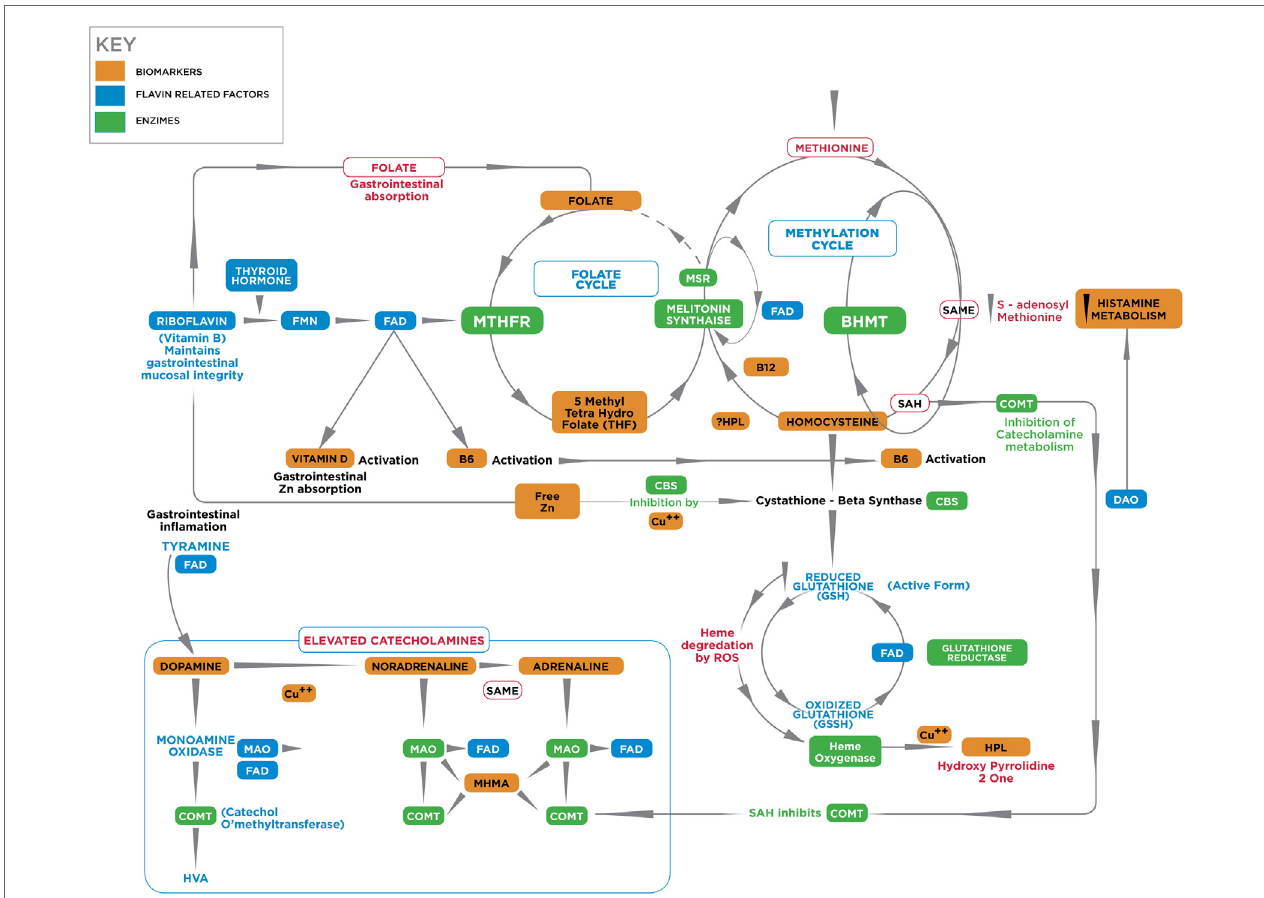
FigUre 1 | a diagrammatic outline of the biochemical territory covered in the MhBP and presented in this manuscript . Enzymes: BHMT, betaine homocysteine methyltrasferase; COMT, catechol-o-methyl-transferase; CBS, cystathione beta synthase, MAT, methionine adenosyltransferase, MTHFR, methylenetetrahydrofolate reductase, SAMe, S-denosylmethionine, MT, methyltransferase, SAHH, S-adenosylhomocysteine-hydrolase, MSR, methionine sulfoxide reductase, MS, methionine synthase. Vitamin cofactors: vitamin B6 (pyridoxine), vitamin B12 (cobalamin), vitamin C, folic acid, 5 methyl tetrahydrofolate. Mineral enzyme cofactors: free (unbound) copper (Cu), zinc. Intermediate substrates: BH4, tetrahydrobiopterin BH2 – dihydrobiopterin; DMG, Dimethylglycine; DOPAL, dihydroxyphenylacetaldehyde; DOPAC, dihydroxyphenylacetic acid; DOPEGAL, dihydroxyphenylglycolaldehyde; DOMA, dihydroxymandelic acid; DHPG, dihydroxyphenylglycal; DOPA, dihydroxyphenylalanine; FAD, flavin adenine dinucleotide, 5HIAA, 5-hydroxyindolacetic acid, HVA, homovanillic acid, MAO, monoamine oxidase; MHMA, 3-methoxy-4-hydroxymandelic acid; MHPG, 4-hydroxy-3-methoxyphenylglycol; SAH, S -adenosylhomocysteine; TMG, trimethylglycine, VMA, vanillylmandelic acid. HPL, urinary